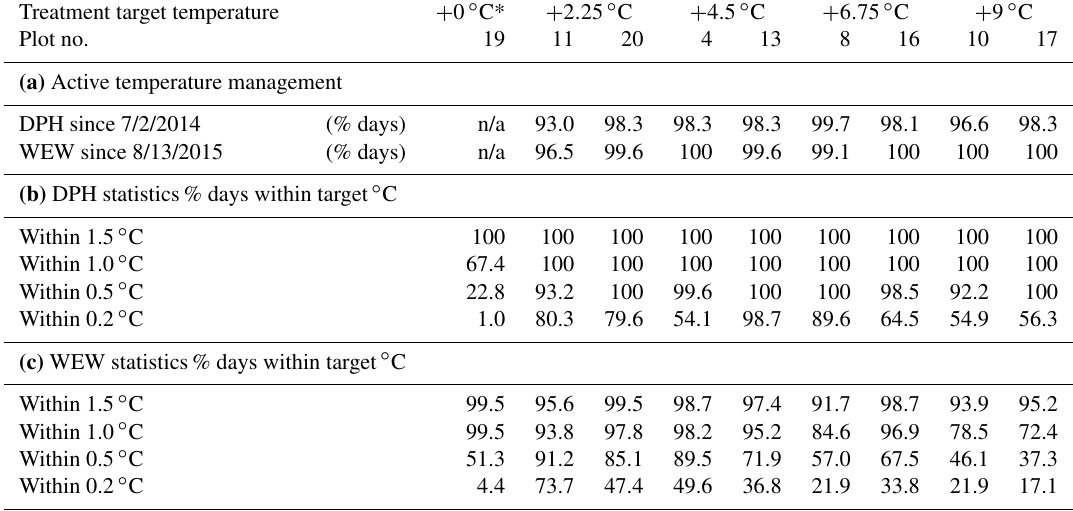
* Data for plot 19 (the second constructed control plot with plot 6 being the primary reference for this table) reflect spatial variation rather than heating system